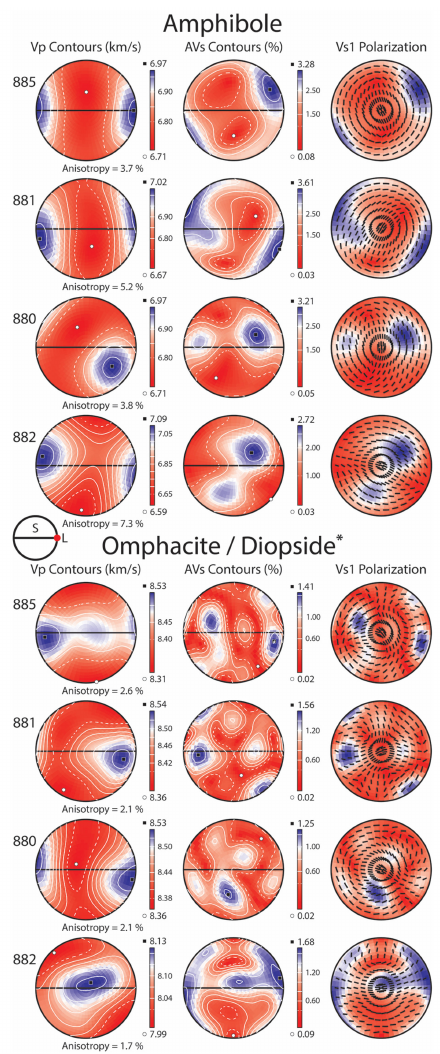
Figure 8. Seismic velocity and anisotropy of amphibole and omphacite. P-wave velocity (V P ) and seismic anisotropy of S-wave (AV S ) are shown. V S 1 polarization indicates the polarization direction of the fast shear wave (V S 1). S and L represent foliation and lineation, respectively. * Diopside for sample